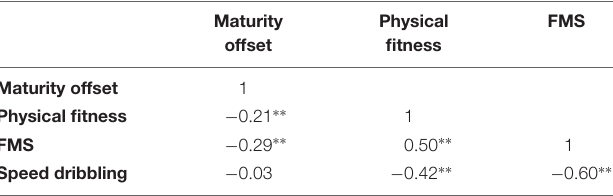
TABLE 3 | Correlation matrix of the study variables.